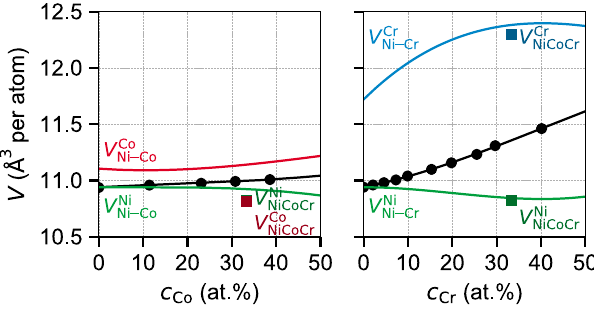
Fig. 3 Alloy atomic volumes for Ni – Co and Ni – Cr binary alloys versus Co and Cr composition (black symbols), respectively, and apparent volumes V solute (cid:1) n for Ni, Co, and Cr versus composition (colored lines). Also alloy shown are the apparent volumes for Ni, Co, and Cr in NiCoCr as measured in Fig. 2 and shown at the Ni 2 Co and Ni 2 Cr compositions (colored